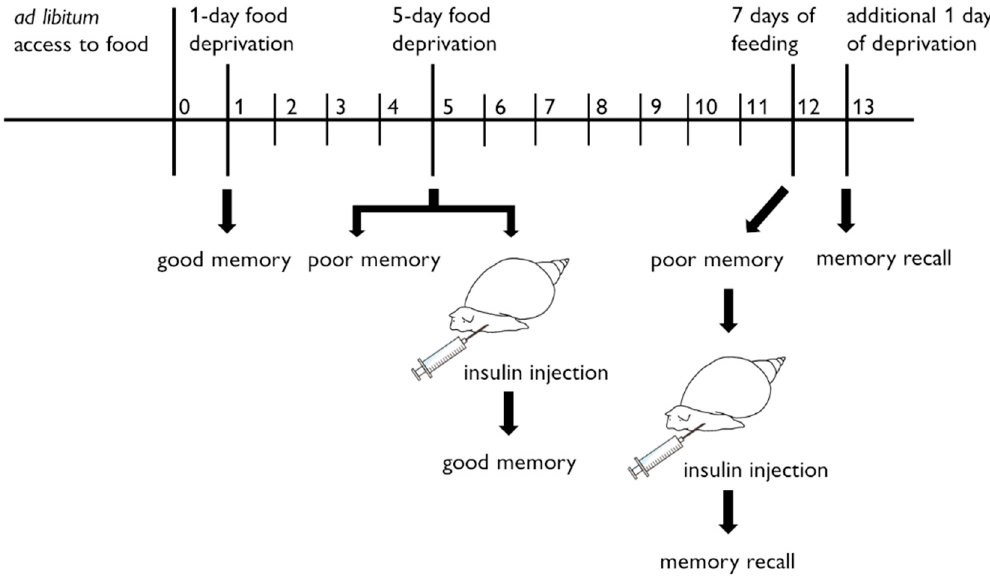
Figure 3. Relation between food deprivation and memory recall in snail conditioned taste aversion (CTA). Snails with ad libitum access to food exhibit poor memory formation. CTA memory is enhanced by 1-day food deprivation, whereas CTA memory is attenuated by 5-day food deprivation. If insulin is injected into the snails after 5 days of food deprivation before the CTA training, the CTA memory is observed. If, after the snails are food deprived for 5 days, they are fed again to keep them healthy for 7 days, they exhibit poor memory. If the snails are again food-deprived for 1 day before memory testing, however, their insulin levels are increased and they recall the CTA memory. On the other hand, if the snails are injected with insulin instead of being subjected to 1-day food deprivation before memory testing, they are able to recall the CTA memory. We have confirmed that an insulin injection decreases hemolymph glucose levels, but the insulin levels and / or the insulin sensitivity are thought to be regulated not only by food intake but also by other factors (Sections 6 and 7).